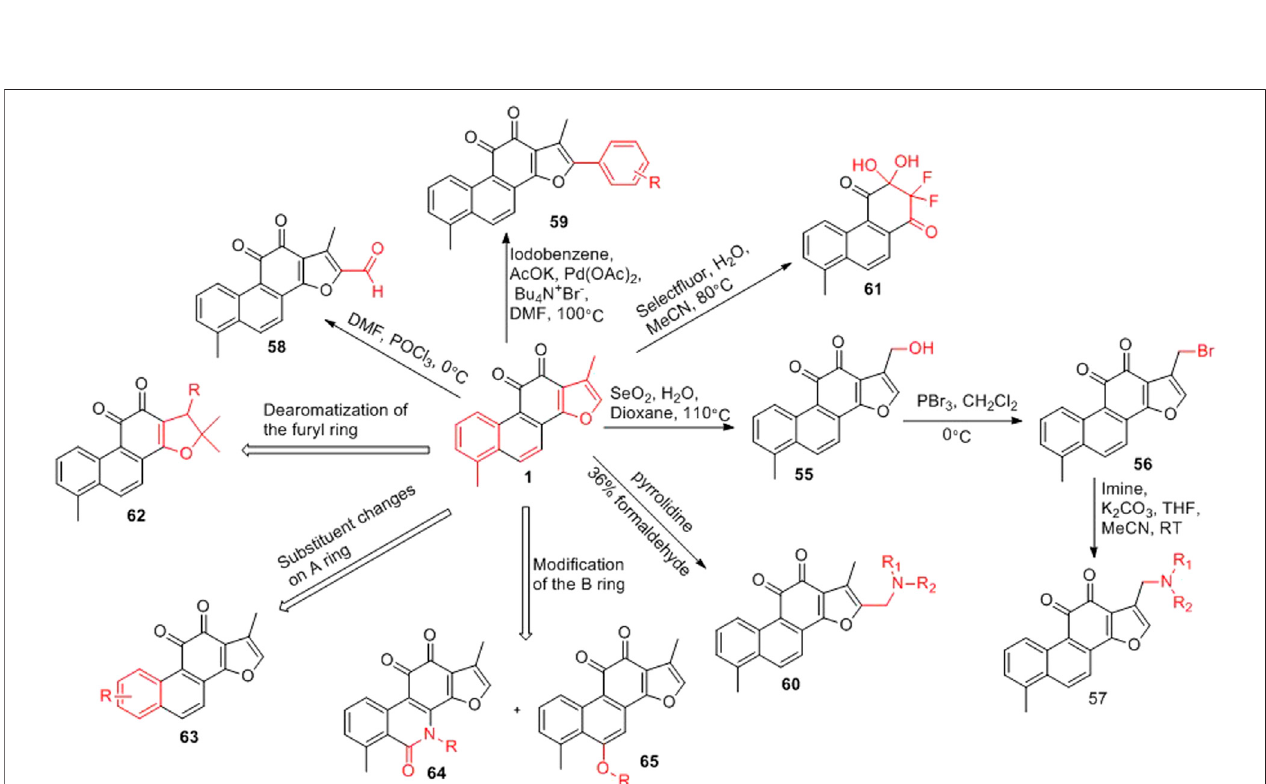
FIGURE 7 | Structural modi fi cation of furan ring, A ring and B ring of tanshinone I.